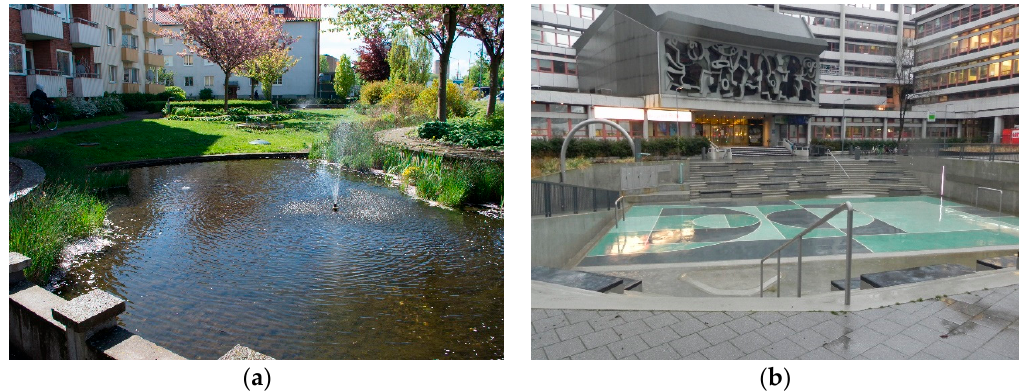
Figure 4. Floodable areas with multifunctional use. ( a ) A pond in Augustenborg Eco-City, Malmö. During heavy rainfall, the area can store water up to the stone edge near the trees to the right (photo by Johanna Sörensen); ( b ) The Water Plaza in Rotterdam. The multifunctional basins prevent surrounding streets from being flooded. The plaza is also used for performances, skating, studying, and group meetings (photo by Misagh